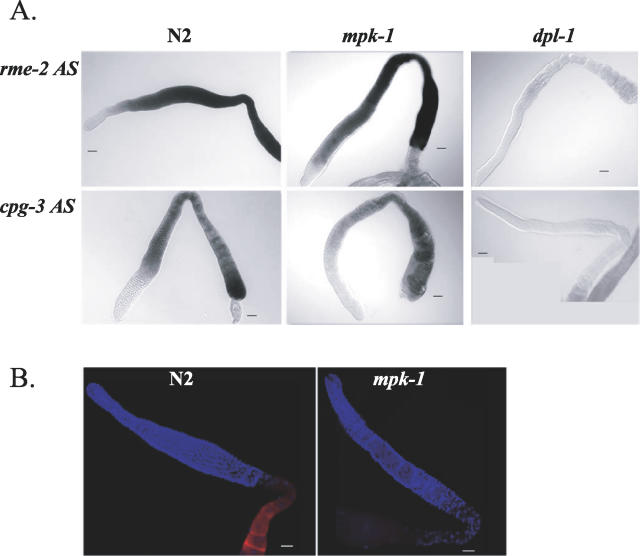
Expression of E2F-Regulated Genes Does Not Require MPK-1 Signaling(A) In situ hybridization of N2, mpk-1, and dpl-1 gonads stained with rme-2 and cpg-3 AS probes. Sense probes showed no signal.(B) N2 and mpk-1 gonads stained with an antibody to the RME-2 protein (red) and DAPI to mark nuclei (blue).Scale bar, 20 μm.